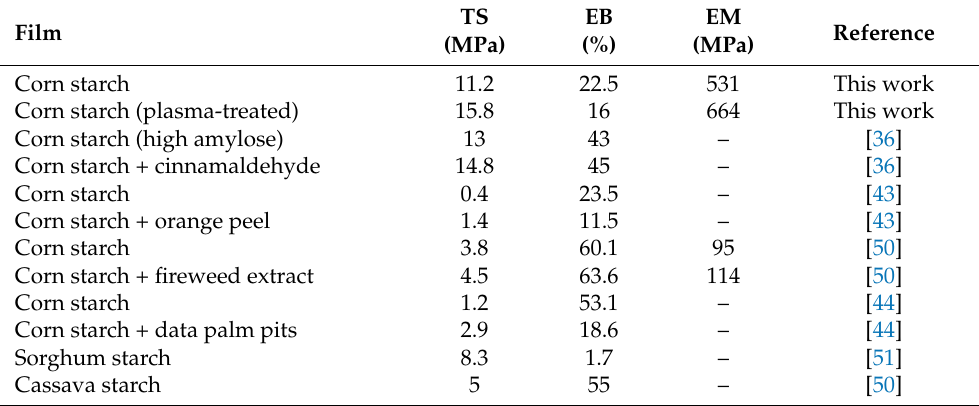
Table 9. Mechanical properties of several starches, bacterial cellulose, and gelatin films reported in the